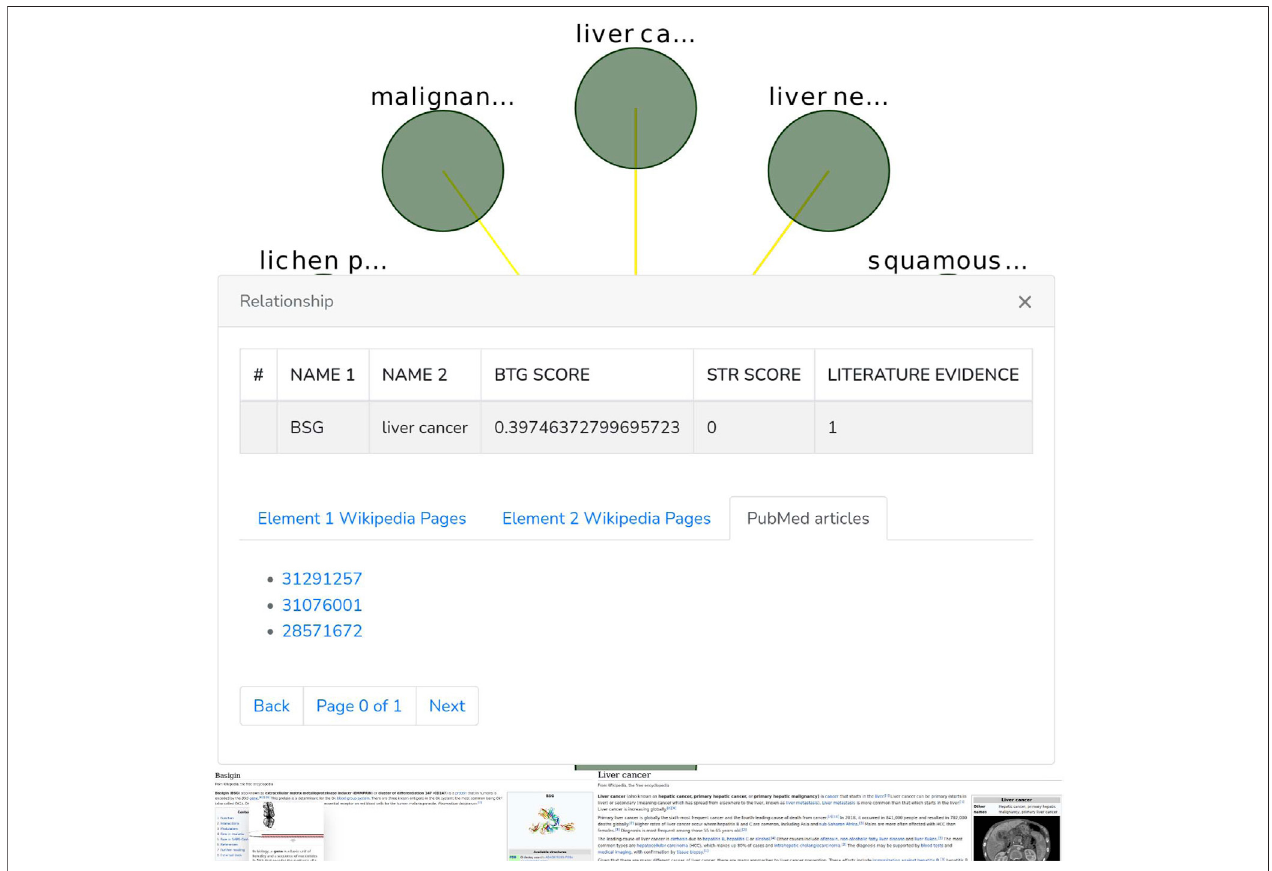
FIGURE 7 | Relationship